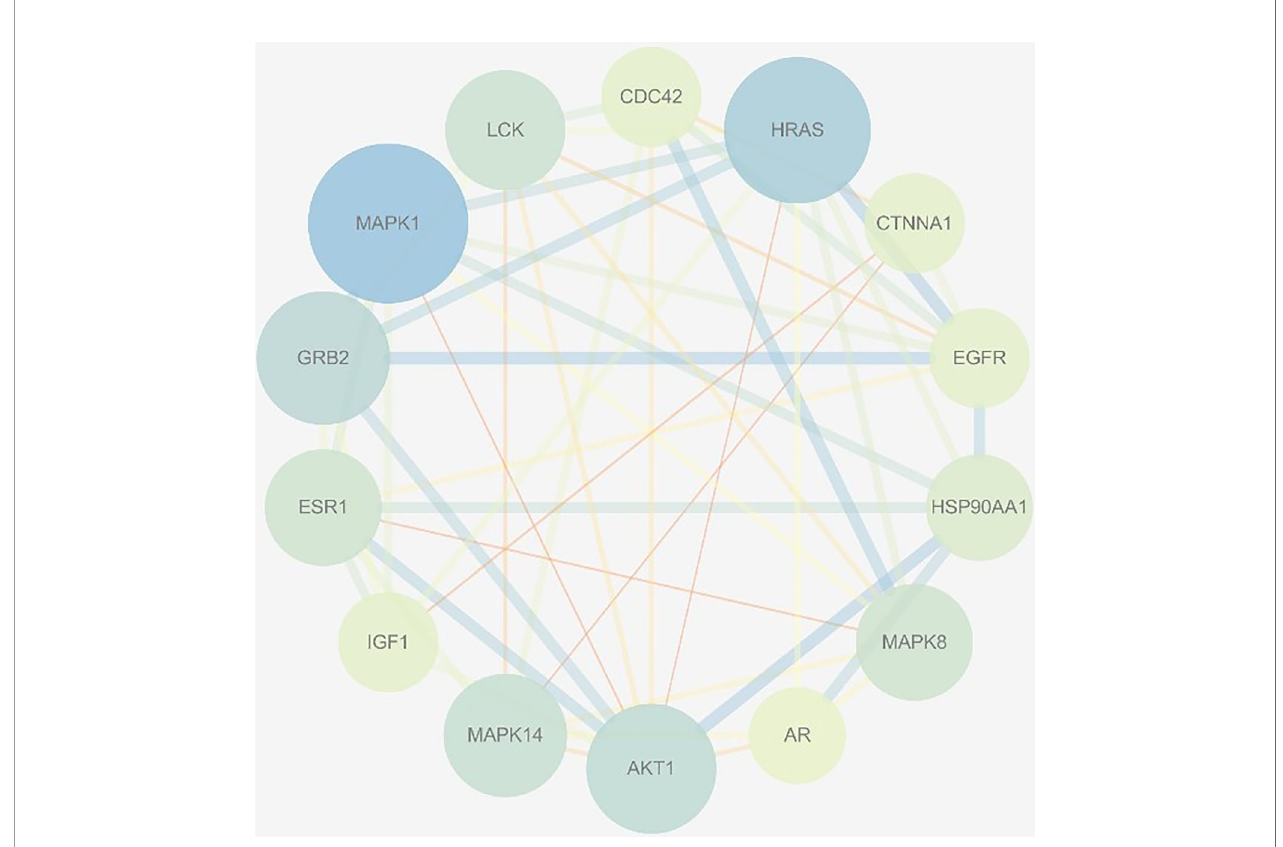
FIGURE 4 | Selected 14 core